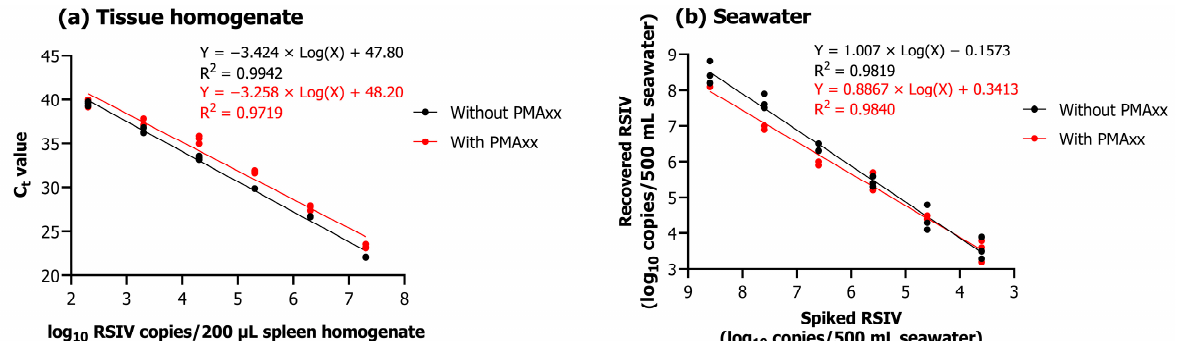
Figure 3. ( a ) qPCR and viability qPCR results obtained using 10-fold serially diluted RSIV-infected tissue homogenate. ( b ) Relationship between spiked RSIV and the number of copies recovered. Ten-fold serially diluted RSIV was concentrated based on iron flocculation, followed by qPCR and viability qPCR. All experiments were performed in triplicate. C t values were plotted against RSIV copy numbers obtained using qPCR and viability qPCR; linear regression equations and correlation coefficients (R 2 ) are shown in the graph.